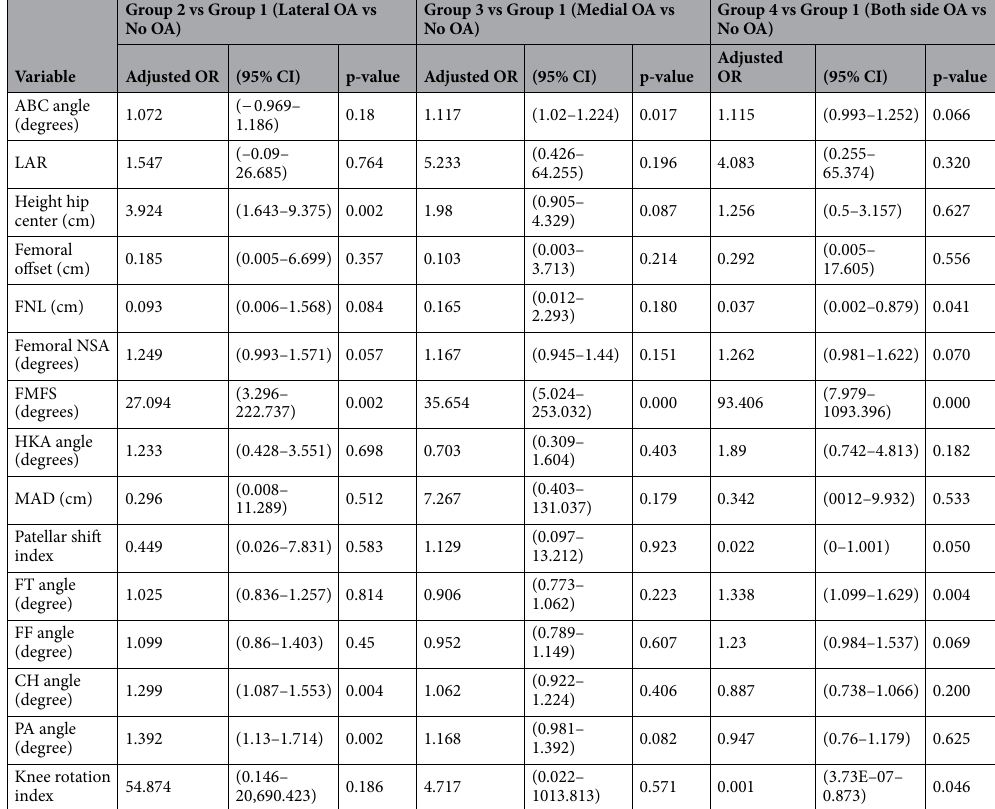
Table 4. Comparison of parameters according to osteophyte compartment in the knee. ABC Abductor angle, LAR Lever arm ratio, FNL Femoral neck length, NSA neck-shaft angle, DHCFA/R distance from the femoral head center to the femoral axis, divided by the radius, FMFS angle between the femoral mechanical axis and the femoral shaft axis, HKA hip-knee-ankle angle, MAD mechanical axis deviation, FT fibular-tibial angle, FF fibular-femoral angle, CH condylar-hip angle, PA tibial plateau-ankle angle, OR odds ratio, CI confidence